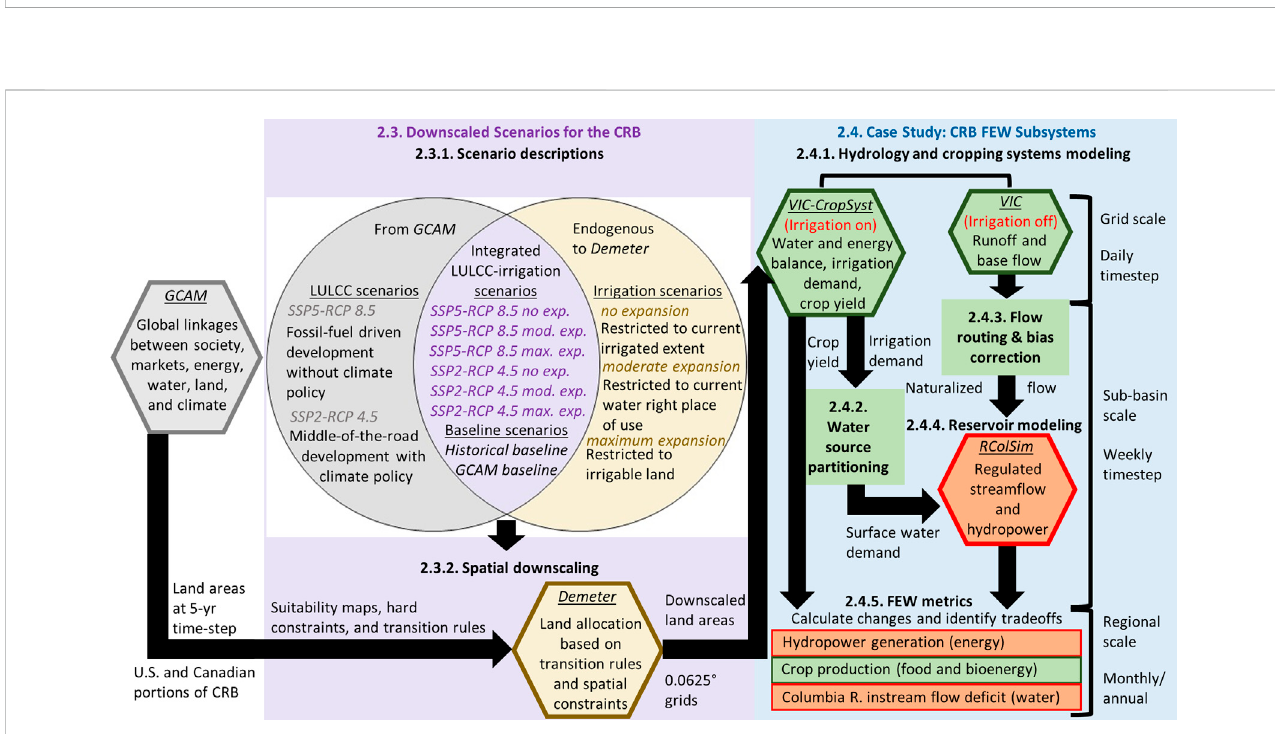
FIGURE 2 Spatial downscaling and multi-model work fl ow. Elements in the purple-shaded box illustrate downscaling LULCC projections from GCAM (grey hexagon) with Demeter (yellow hexagon). The scenariosshown intheVenn Diagram are constituted ofLULCCscenarios from GCAM and irrigation scenarios endogenous to Demeter. FEW subsystems modelling is shown in the blue-shaded box. The cropping systems and hydrology model, VIC-CropSyst (green hexagon), simulates naturalized stream fl ow, irrigation demand, and crop yield. Naturalized stream fl ow and water demand drive the reservoir model, RColSim (orange hexagon). Outputs from the two models are then used to calculate FEW